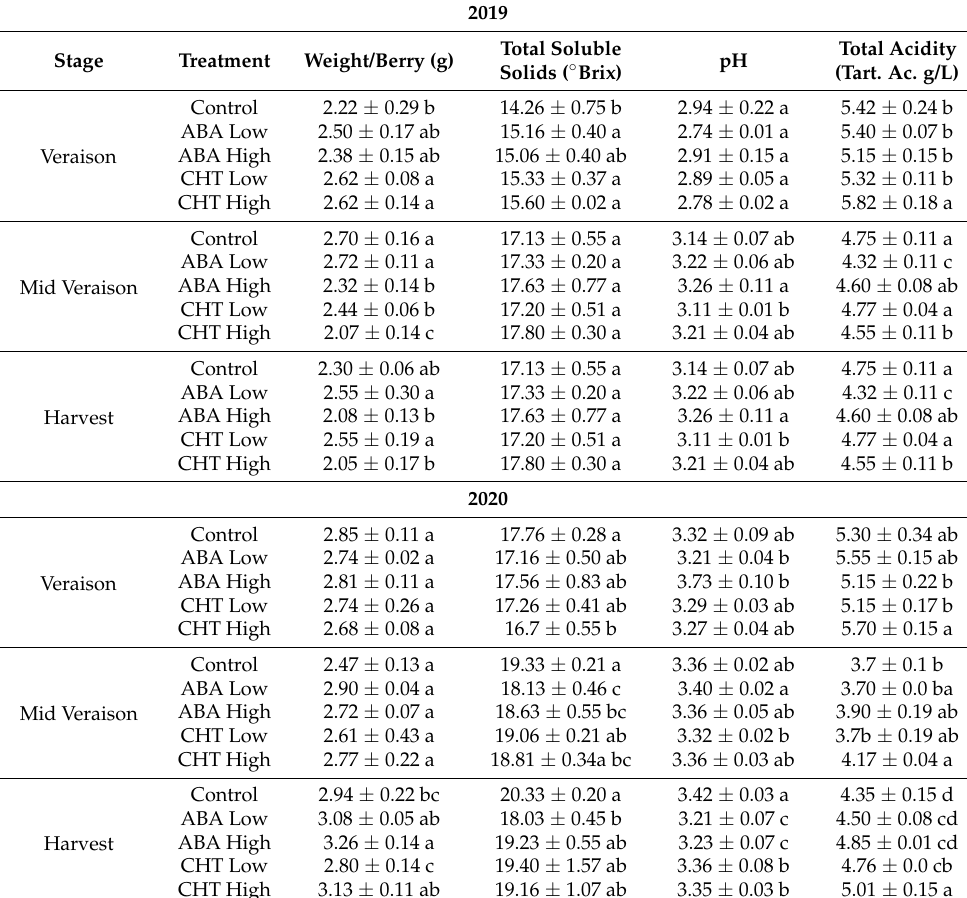
Table 1. Physiochemical characteristics of grapes during